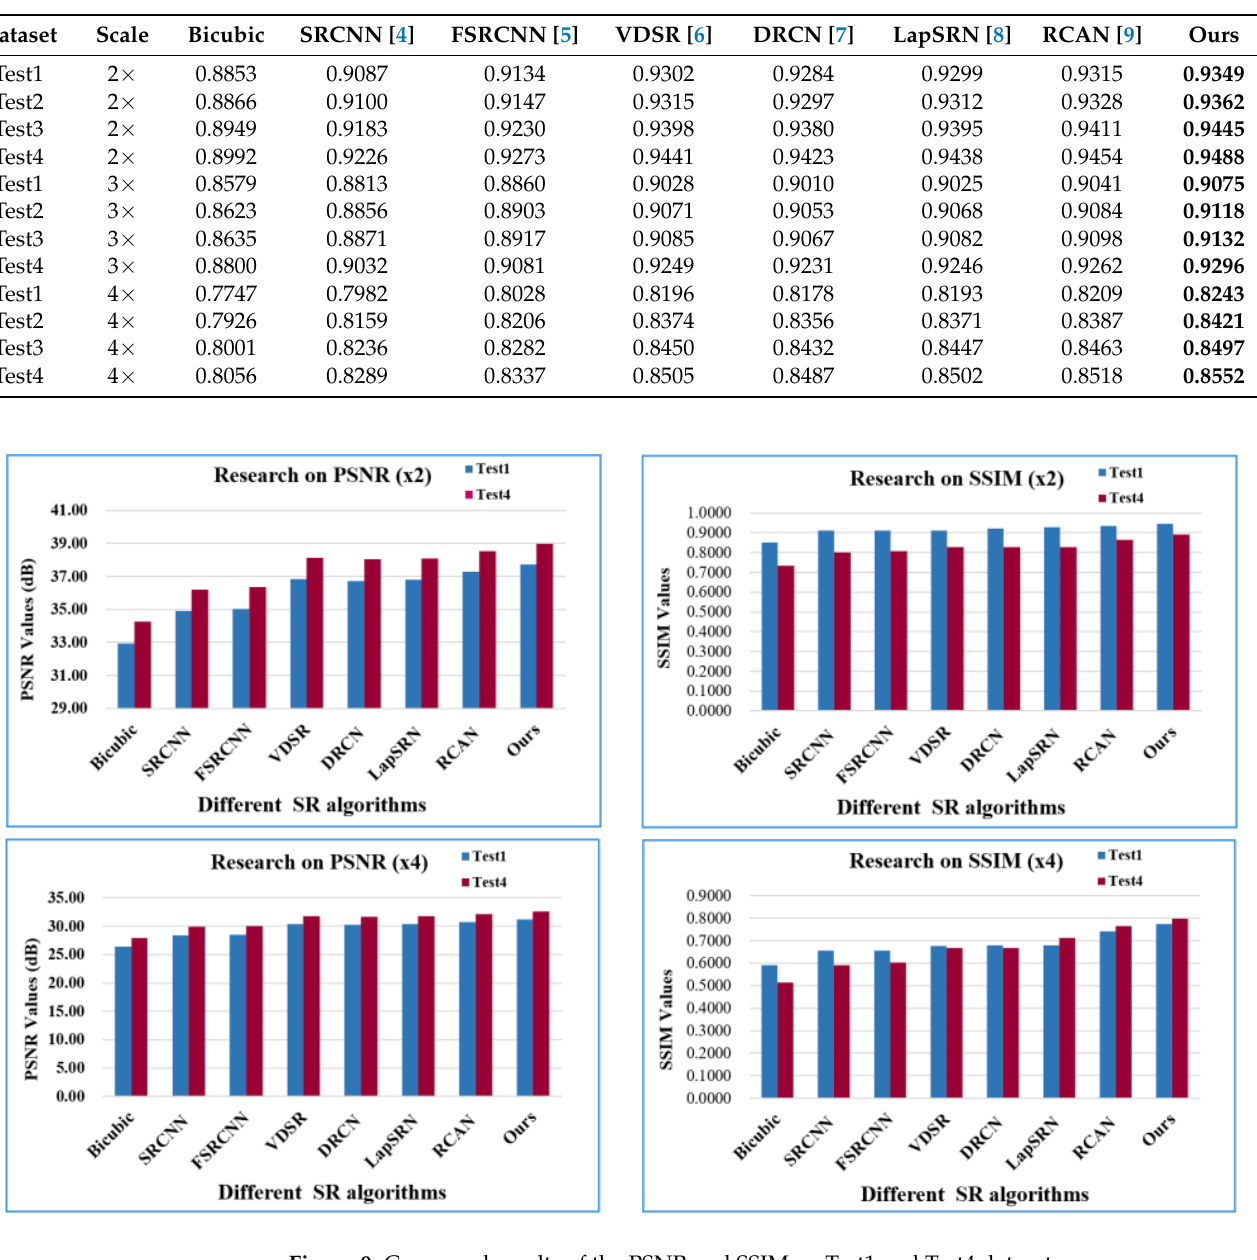
Table 4. Average SSIM for different algorithms at Test1, Test2, Test3 and Test4 datasets.